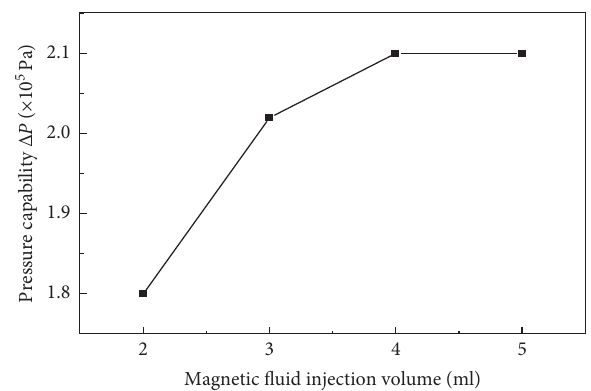
Figure 11: Influence of volume injection on magnetic fluid sealing ability.